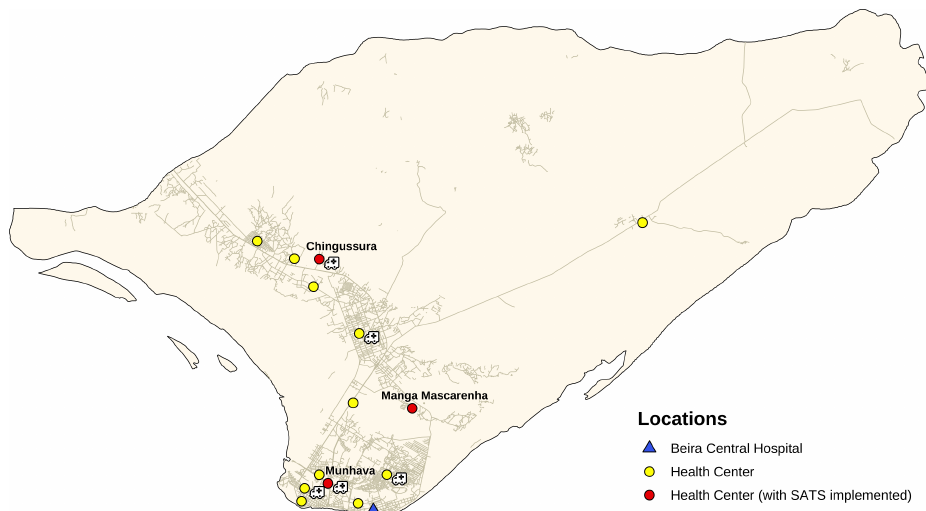
Figure 1. Distribution of health centres (HCs) and ambulances in